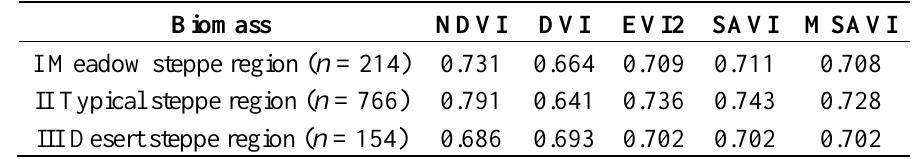
Table 2. Relationship between biomass and VIs in various regions. All relationships exhibit significant correlations. The correlation coefficients are calculated using all field samples (including model samples and verification samples) in different steppe regions.